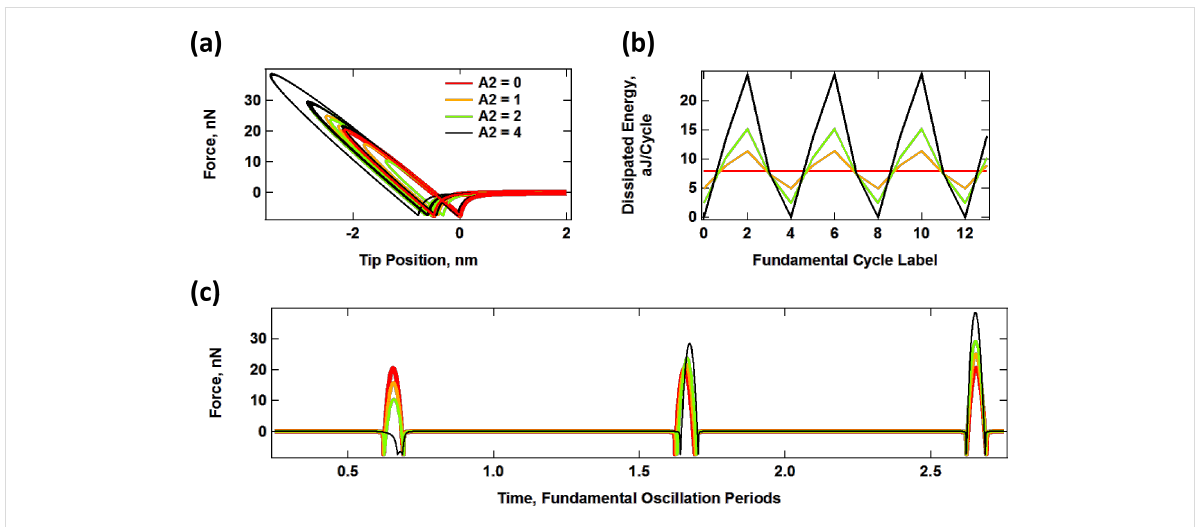
Figure 7: Interaction of an SLS surface with a probe oscillating along a realistic AM-OL bimodal trajectory obtained by simulating the cantilever dynamics. (a) Force–distance trajectories for varying A 2 ; (b) dissipated energy per cycle for successive fundamental cycles and varying A 2 ; (c) example of successive tip–sample impacts for the same cases. The first eigenmode free amplitude was 100 nm in all cases and A 2 is the free oscillation amplitude of the second eigenmode (in nm). The cantilever position is z c = 80 nm. The SLS parameters are the same as in Figure 5 and Figure 6. The eigenfrequency ratio of the first two eigenmodes is 6.25 instead of 6.21, which was used in Figure 5 and Figure 6. This different ratio was chosen to illustrate a different impact periodicity (the periodicity is 4 in this case, whereas it is 100 for Figure 5 and Figure 6). The color coding is the same in all